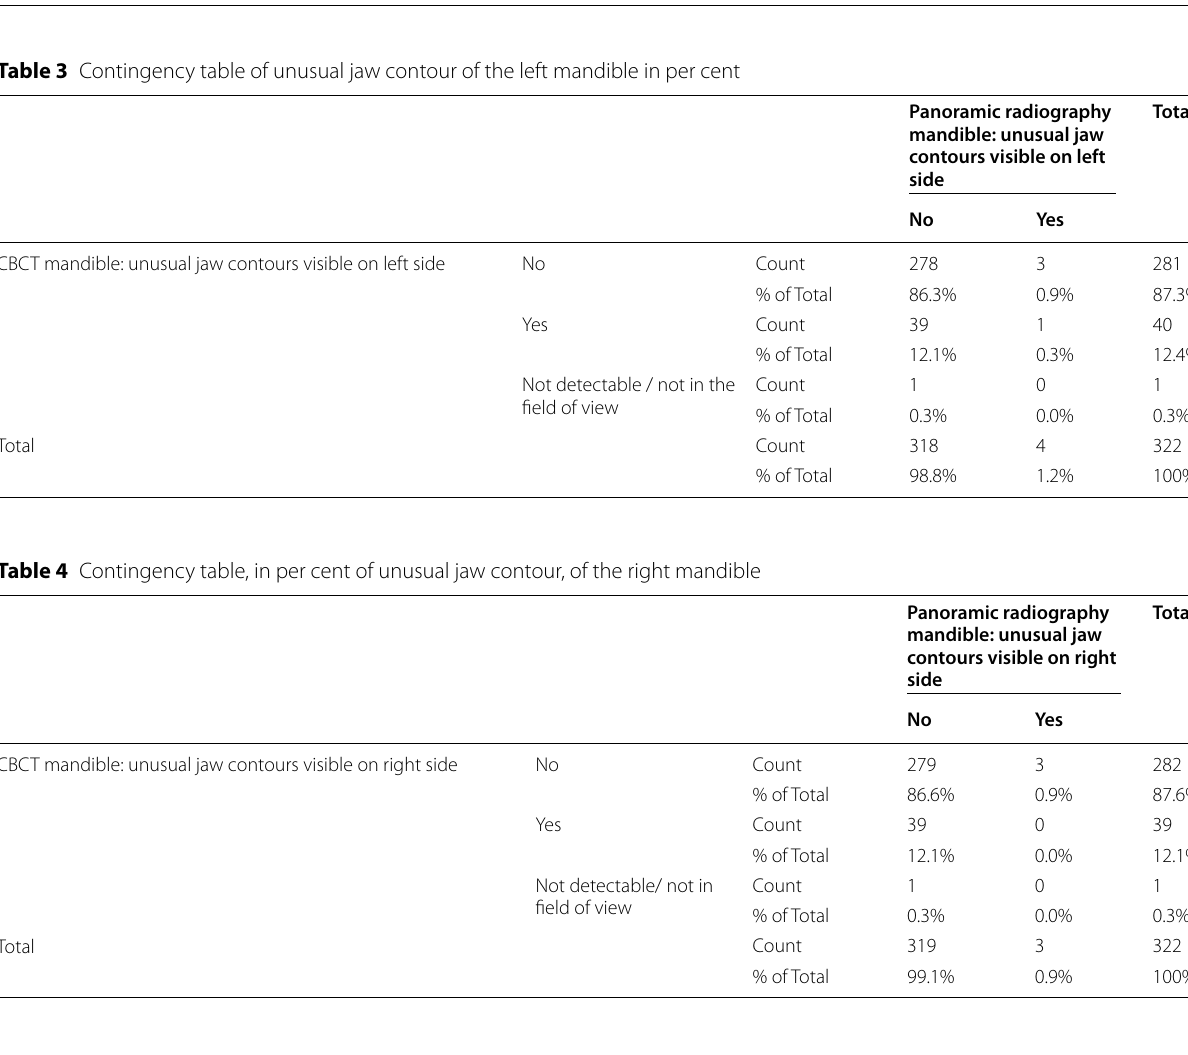
Table 3 Contingency table of unusual jaw contour of the left mandible in per cent